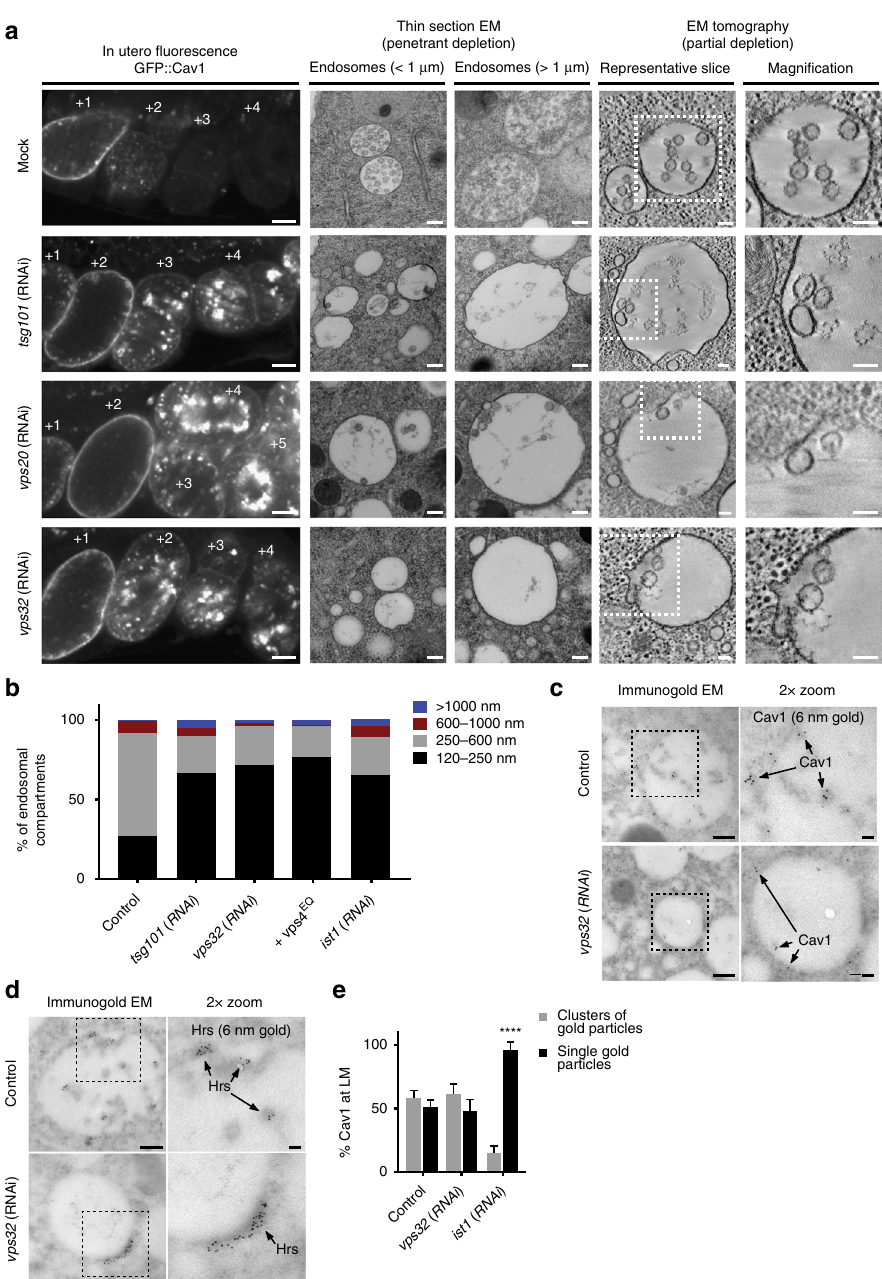
Fig. 3 ESCRT-III is required for membrane deformation and cargo retention on MVEs in vivo. a Control ( n = 35, mock-treated animals) and RNAi-treated animals ( n = 12, Tsg101 depleted animals; n = 11, Vps20 depleted animals; n = 35, Vps32-depleted animals) expressing GFP::Cav1 were imaged using fl uorescence (left panels) and electron microscopy in utero. The effects of penetrant ESCRT subunit depletion were analyzed by thin-section electron microscopy (middle panels; n = 54, mock-treated animals; n = 77, Tsg101 depleted animals; n = 63, Vps20 depleted animals; n = 74, Vps32-depleted animals), and partial depletions were conducted to enable ILV formation, which was examined by electron tomography (right panels; n = 118, mock-treated; n = 15, Tsg101 depletion; n = 10, Vps20 depletion; n = 32, Vps32 depletion). Representative images are shown. Bars, 10 μ m (left panels, fl uorescence imaging), 200 nm (middle panels, thin-section EM), and 100 nm (right panels, tomographic slices). b The size distribution of endosomal compartments in the one-cell stage embryo was determined for control animals ( n = 86), ESCRT subunit depleted animals ( n = 212, Tsg101 depleted animals; n = 77, Vps32- depleted animals; n = 110, Ist1-depleted animals), and transgenic animals expressing Vps4 E219Q ( n = 112). c The distribution of Cav1 at endosomes was determined by immunogold labeling in control ( n = 122) and Vps32-depleted one-cell stage embryos ( n = 40). Micrographs shown are representative of the endosomal compartments analyzed for each condition. Bars, 200 nm (left panels) and 50 nm (right, zoomed panels). d The distribution of Hrs (ESCRT- 0) at endosomes was determined by immunogold labeling in control ( n = 42) and Vps32-depleted one-cell stage embryos ( n = 36). Micrographs shown are representative of the endosomal compartments analyzed for each condition. Bars, 200 nm (left panels) and 50 nm (right, zoomed panels). e Quanti fi cation of Cav1 distribution in control ( n = 37) and ESCRT-III subunit depleted embryos ( n = 25, Vps32 depletion; n = 33, Ist1 depletion) was determined using immunogold labeling, as described in panel 1 f. Standard error of the mean is shown in each case. **** p < 0.0001, using a two-way ANOVA with Dunnett ’ s